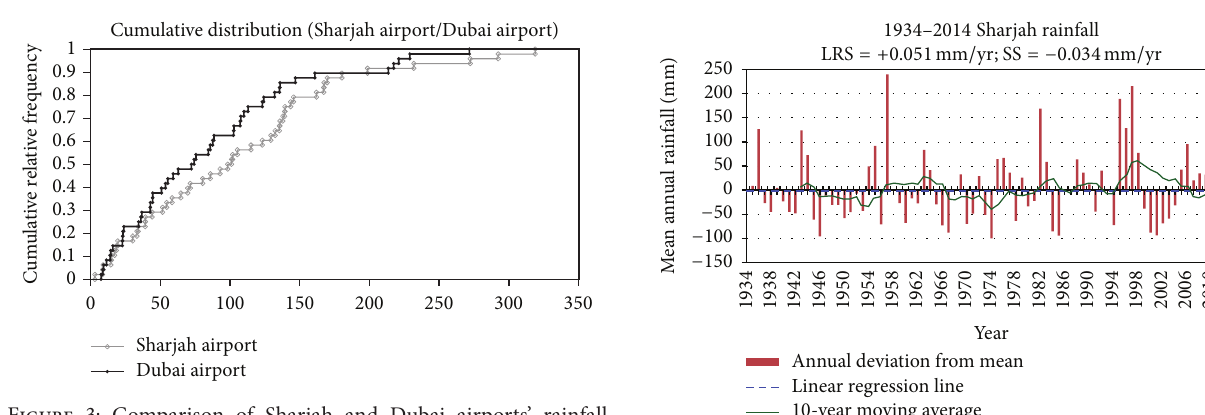
Figure 3: Comparison of Sharjah and Dubai airports’ rainfall distributions using Kolmogorov-Smirnov cumulative frequency distribution.